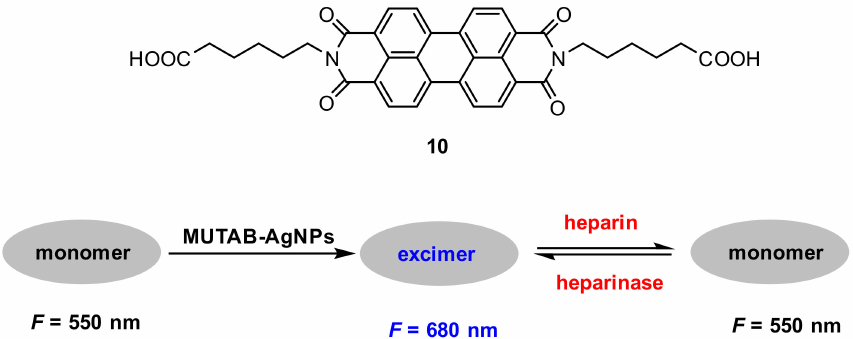
Figure 27. Chemical structure of probe 10 and schematic representation for sensing heparin and